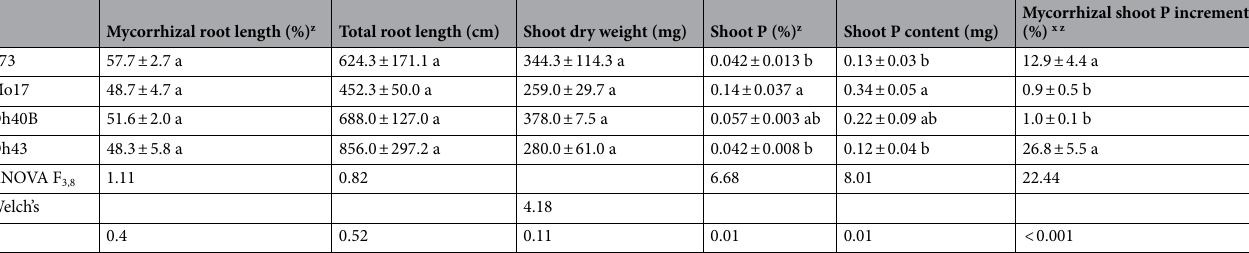
Table 1. Phenotypic traits (mean ± standard error of the mean) of Zea mays plants belonging to four inbred lines, grown in symbiosis with Rhizoglomus irregulare under low phosphorus (P) availability (0.47 mg kg −1 ). For each trait, F and P values resulting from one-way ANOVA, or Welch’s test for unequal variances, are reported. In columns, values followed by the same letter do not differ significantly at P ≤ 0.05 by Tukey’s HSD or Tamhane T2 test. z statistics performed on arcsine square-root-transformed data. x calculated as: (Mycorrhizal plant shoot P content − (mean control P content)/(mean control P content).